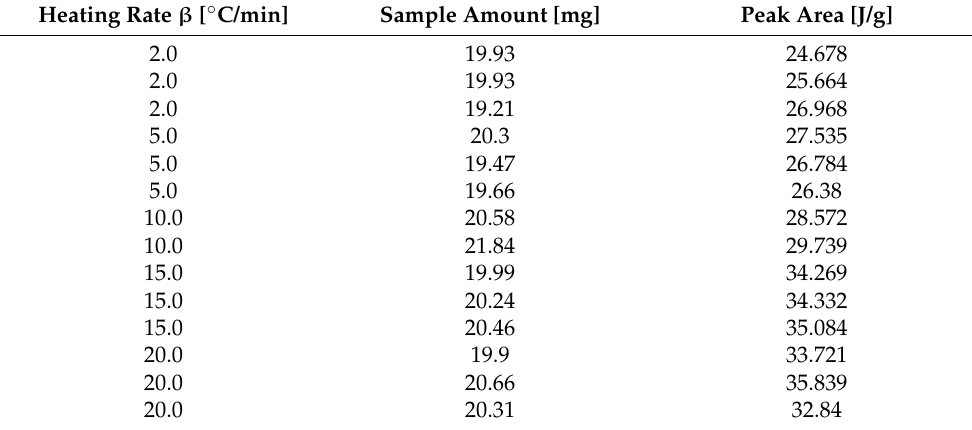
Table 1. Exothermic effect expressed as the area of exothermic peak from DSC experiments at different heating rates including the